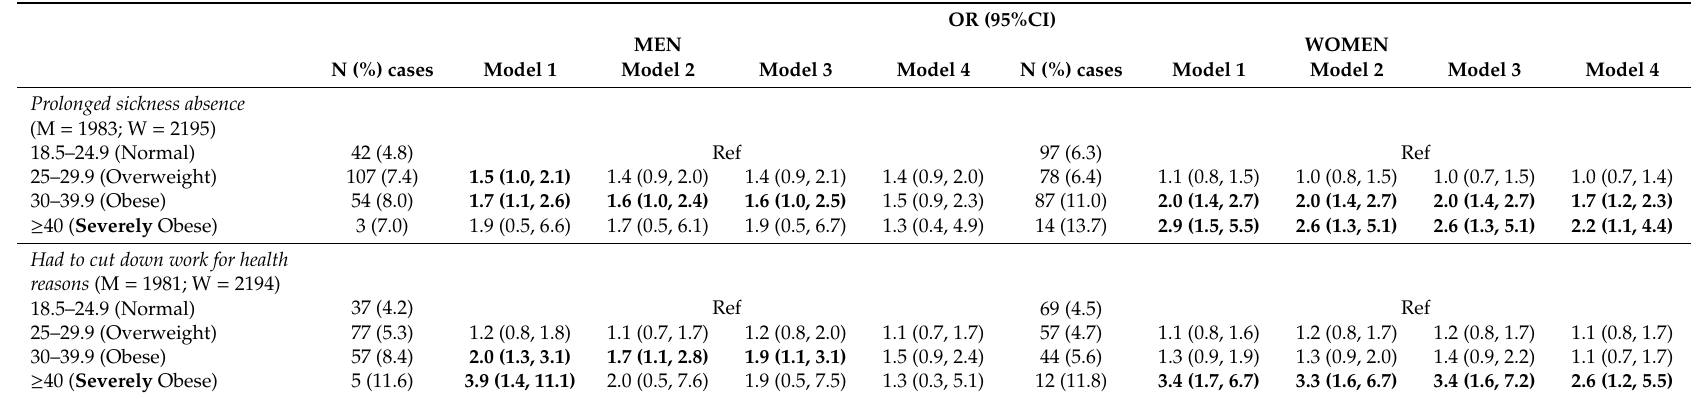
Table 3. Odds ratio (OR) and 95%CI for work outcomes within 2 years of follow-up by categories of body mass index (BMI) for men and women. (Bold type denotes statistical significance at the p < 0.05